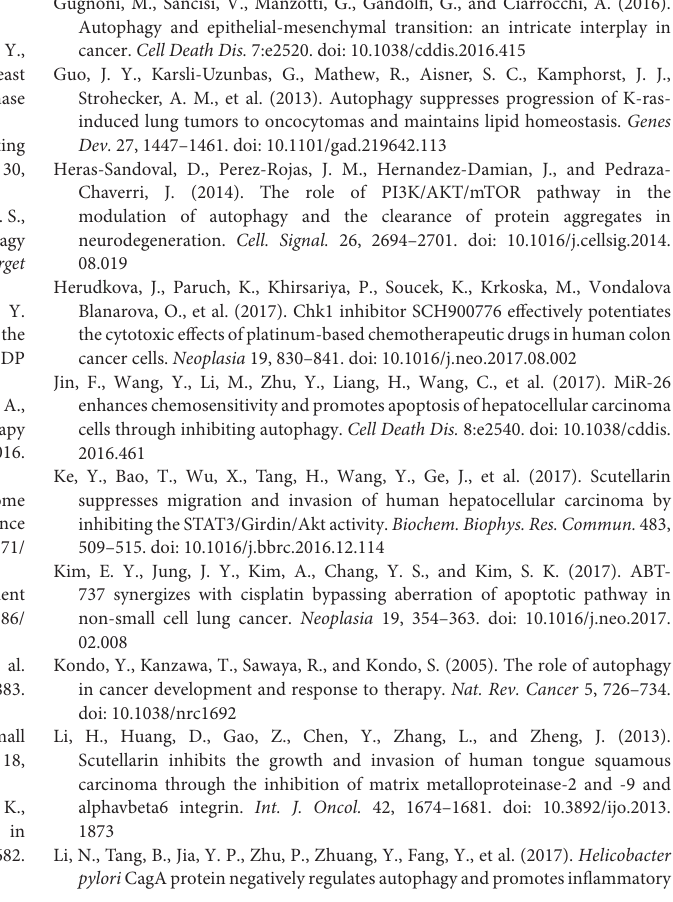
FIGURE S2 | (A) Western blot analysis showing caspase-3, cleaved caspase-3 and PARP expression levels in A549/DDP cells treated with cisplatin, or scutellarin, or the combination. Actin was used as loading control. FIGURE S3 | (A) Western blot analysis of p53 protein in A549/DDP cells treated by cisplatin, or scutellarin, or the combination. (B) The effect of p53 inhibitor PFT on p53, caspase-3, cleaved caspase-3 and PARP expression levels were measured by western blot analysis. (C) The expression of p-ERK1/2, ERK1/2 were determined by western blot analysis. (D) The level of p-ERK1/2, ERK1/2, p53 in A549/DDP cells were measured in the presence of ERK1/2 specific inhibitor U0126. FIGURE S4 | (A) A549/DDP cells were treated with cisplatin or scutellarin, or the combination for 48 h, the expression of p62 and conversion of LC3-I to LC3-II were measured by western blotting. (B) Western blot analysis of p62 and LC3 in A549/DDP cells incubated with autophagy inhibitor HCQ. FIGURE S5 | (A) Cells were treated by cisplatin with or without scutellarin, the protein expressions of AKT and p-AKT were determined by western blotting. (B) The expression levels of LC3, AKT, p-AKT were detected by western blotting in A549/DDP cells coincubated with MK-2206. (C) Western blot analysis of the protein of c-met . (D) The effect of crizotinib on the expression of LC3, AKT, p-AKT, c-met was analyzed by western blot analysis. FIGURE S6 | (A) The expression levels of LC3, p62, p53, p-ERK1/2, p-AKT, c-met in mice tumor were detected by western blot